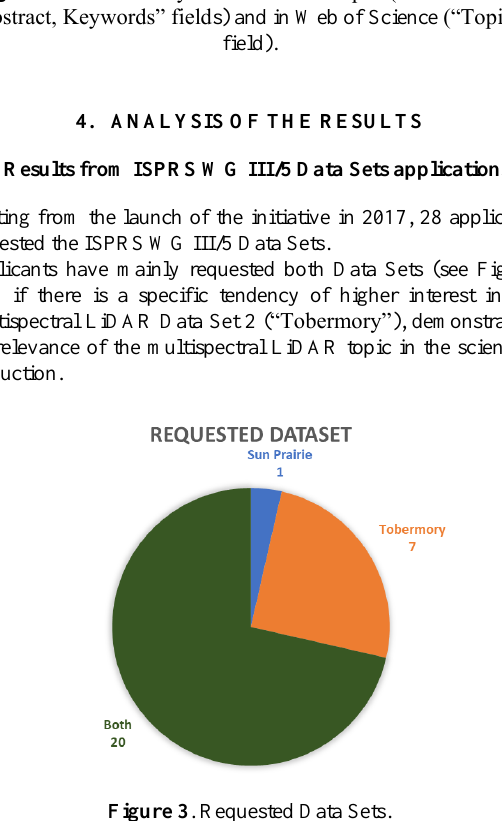
Figure 2 . Research keywords used in Scopus (“Article Title, Abstract, Keywords” fields) and in Web of Science (“Topic” field).